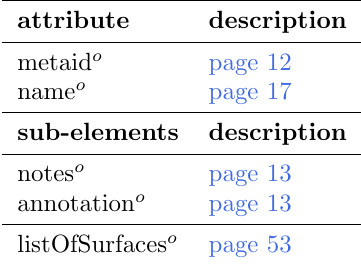
Listing 2.54 shows the use of the plot3D